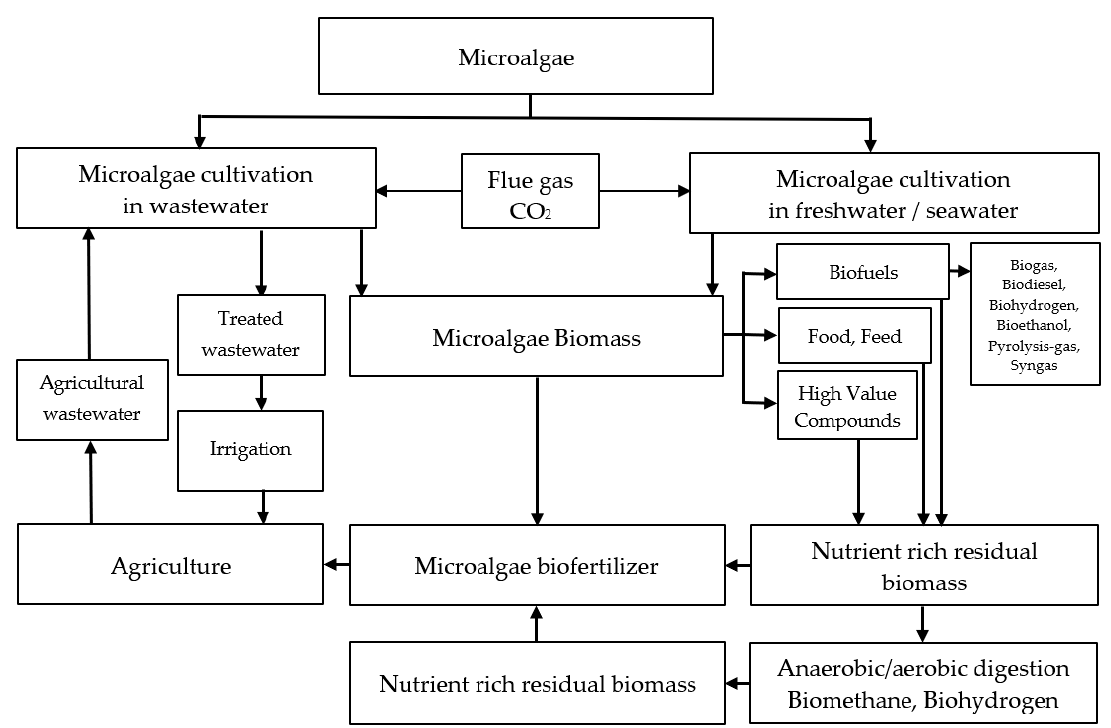
Figure 8. Microalgae biomass in a comprehensive biorefinery concept.